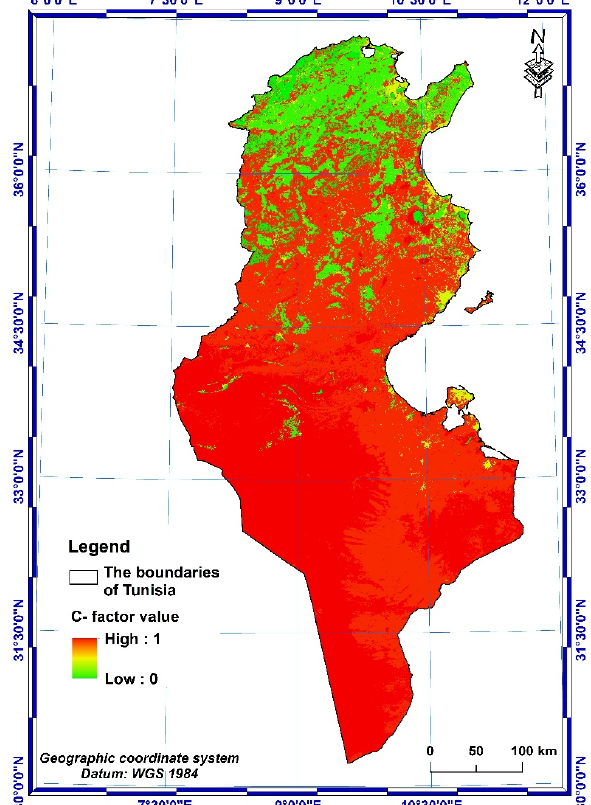
Figure 12. C-factor spatial distribution.